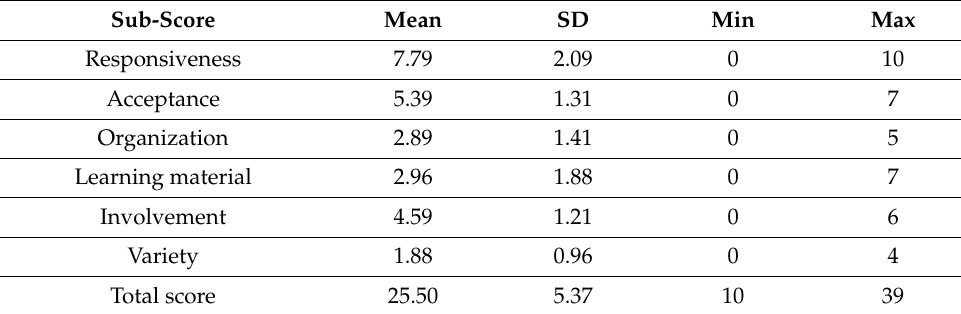
Table 4. Descriptive statistics of HOME scores ( n =